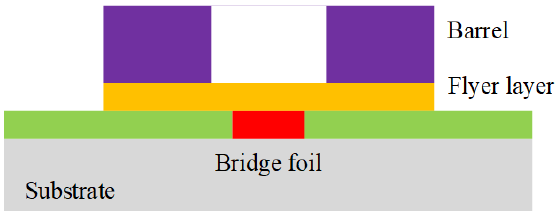
Figure 4. Schematic diagram of electrical exploding foil accelerator.